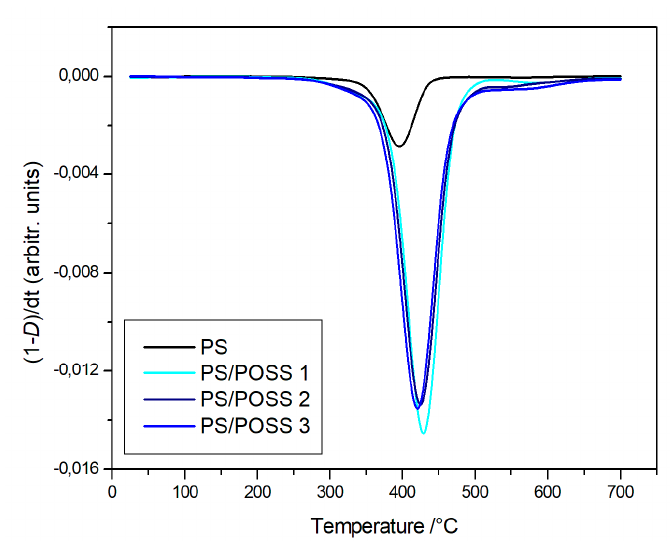
Polymers 2019 , x , x FOR PEER REVIEW Figure 8. Differential thermogravimetric curves, in an inert atmosphere, for PS and samples 1 , 2 and 3 .